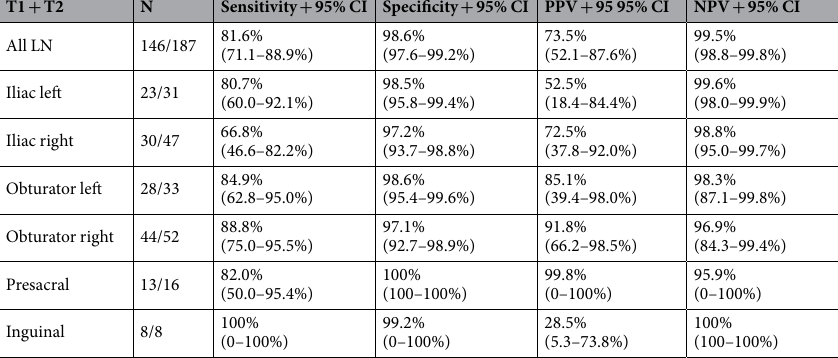
Table 3. Overall and region-based detection rate using combined T1 + T2 + DWI sequence MRI evaluation. This table summarizes the region-based analysis of the lymph node metastases in MRI using T1 combined with T2 and DWI sequence evaluation. The columns present number, sensitivities, specificities, positive and negative predictive value including 95% confidence interval. The rows are fielded in the six defined anatomical regions iliac left and right, obturator left and right, presacral and inguinal region. Abbreviations: LN = Lymph nodes, PPV = positive predictive value, NPV = Negative predictive value, CI = 95% Confidence